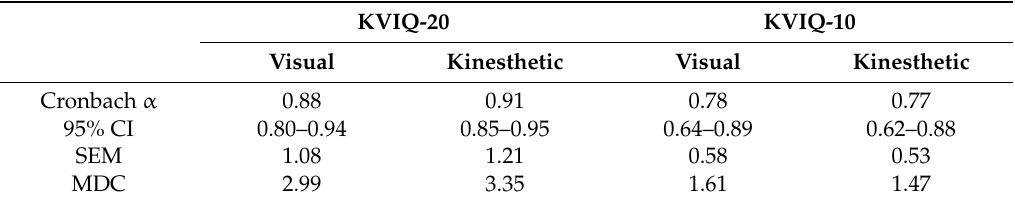
Table 2. Internal consistency of the KVIQ-20/KVIQ-10.